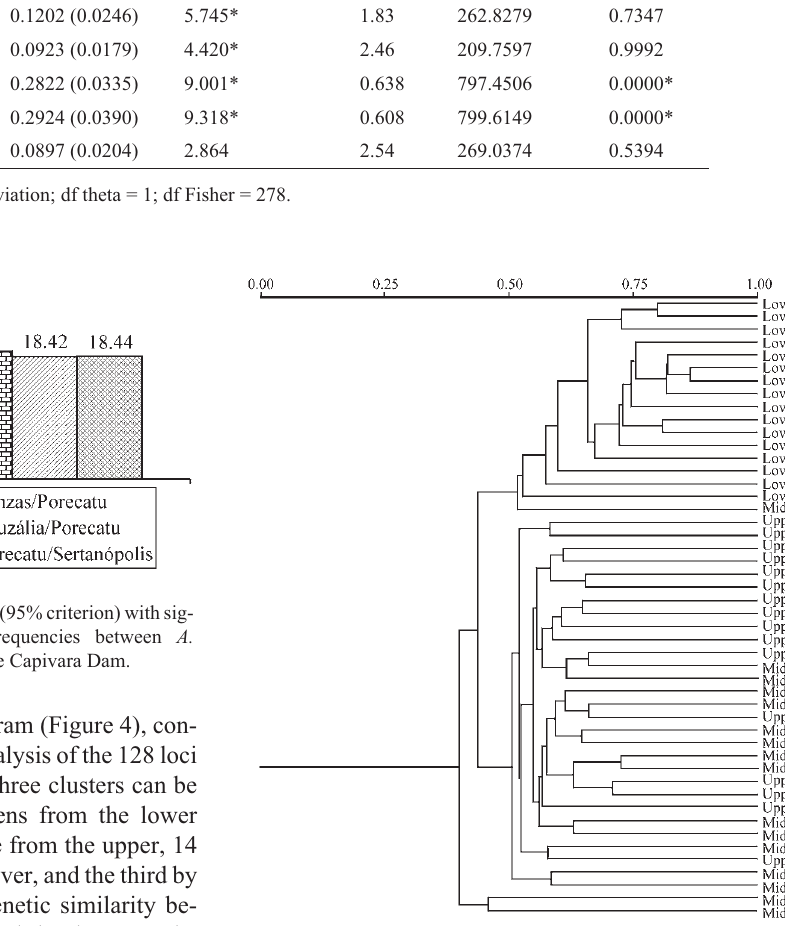
Figure4 -GeneticsimilaritydendrogramgeneratedwiththeJaccardcoef- ficient and UPGMA algorithm, applied to RAPD data, for A. altiparanae from the lower, middle and upper Paranapanema River.